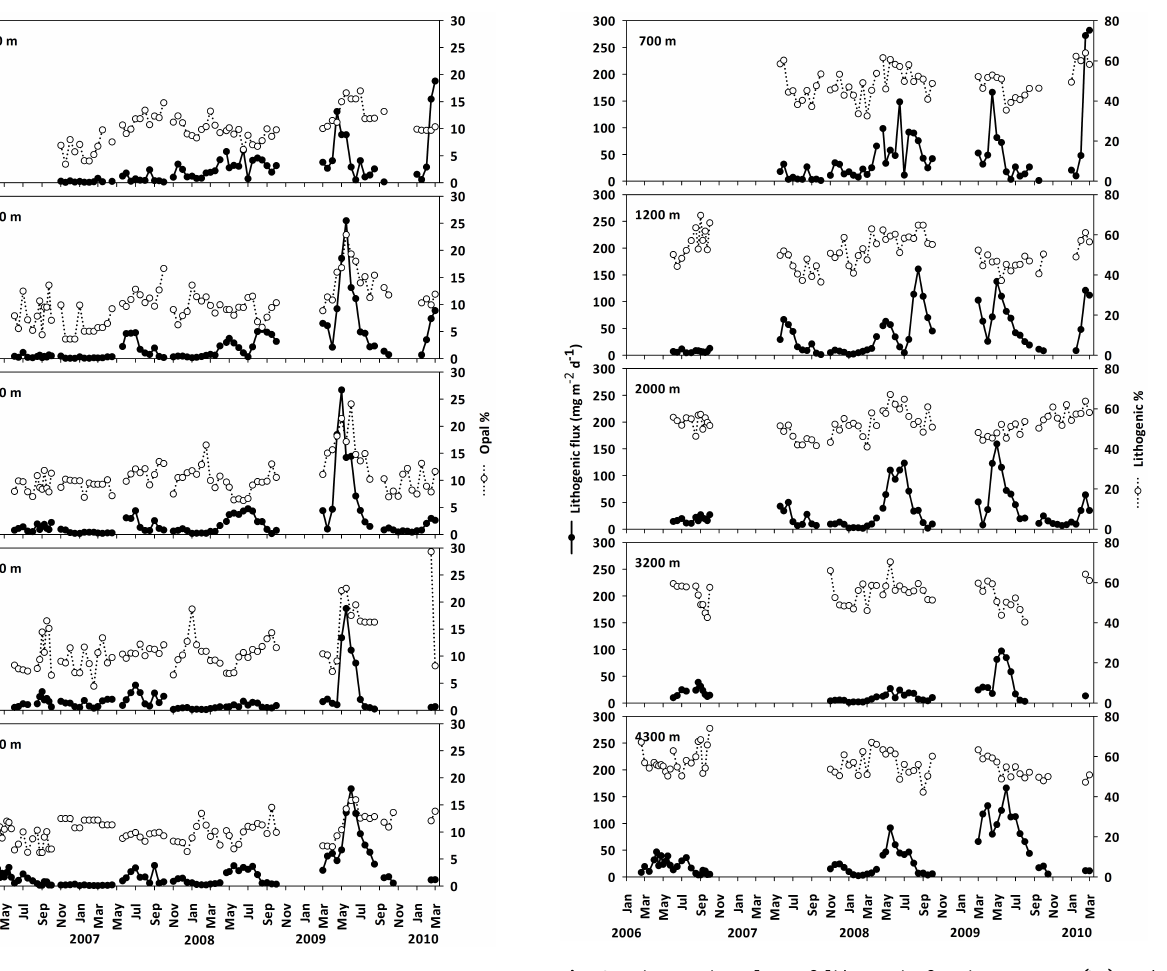
Fig. 8. Time-series plots of opal content (%) and fluxes (mgm − 2 d − 1 ) of downward settling particles collected by sediment traps during the course of the long-term experiment in NESTOR site.